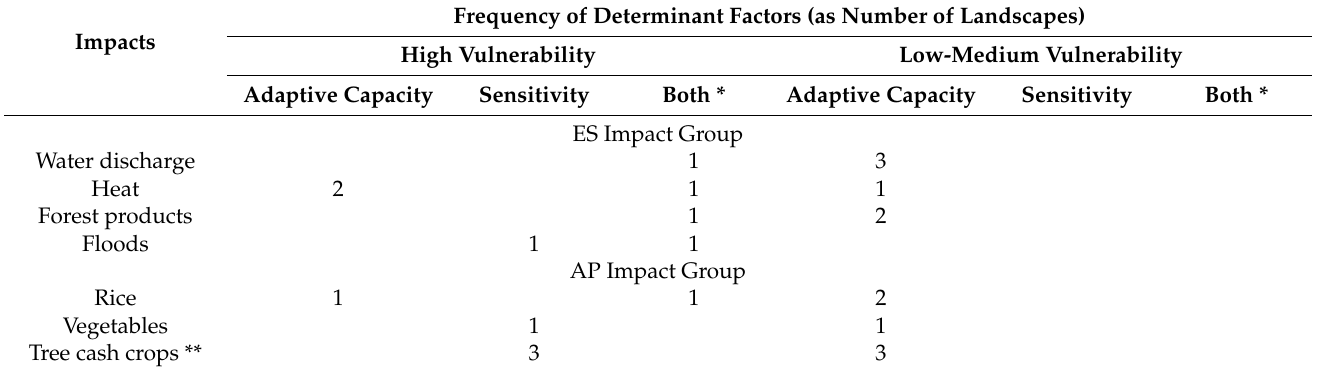
Table 4. Vulnerability levels and the perceived determinant factors of adaptive capacity, sensitivity, or both.